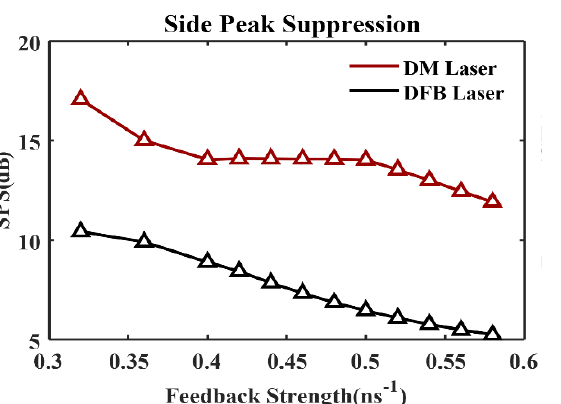
Figure 9. Numerical simulation of SPS of the generated microwave as a function of the feedback strength utilizing DM laser model and DFB laser model with the injection parameters ( Δ f , η ) = (15 GHz, 8 ns − 1 ).